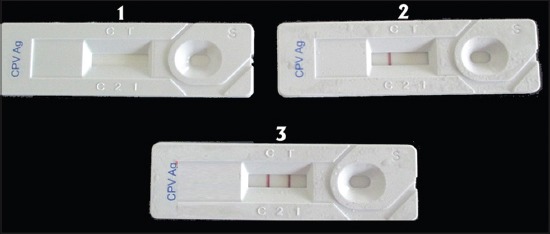
Immunochromatographic strip test (representation)1. Immunochromatographic strip test device2. Negative test result3. Positive test result